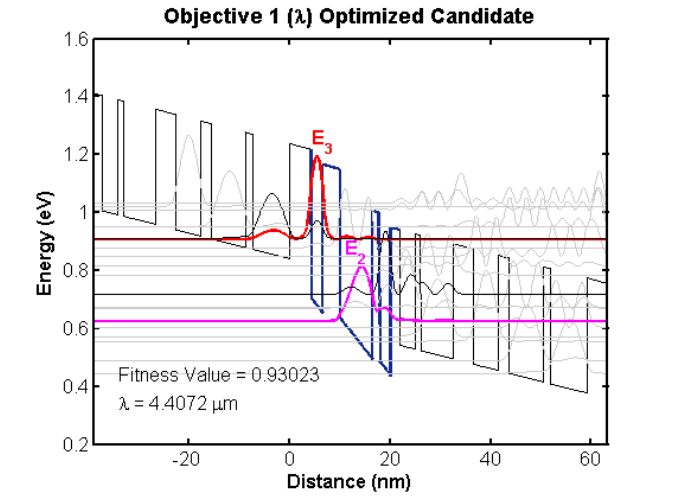
Figure 8. Al x Ga 1 − x As/In y Ga 1 − y As QC laser candidate simulated on GaAs (111) with top objective (1) fitness rank given a training initial population. Relevant wave functions, E 3 and E 2 are in bold and colored.